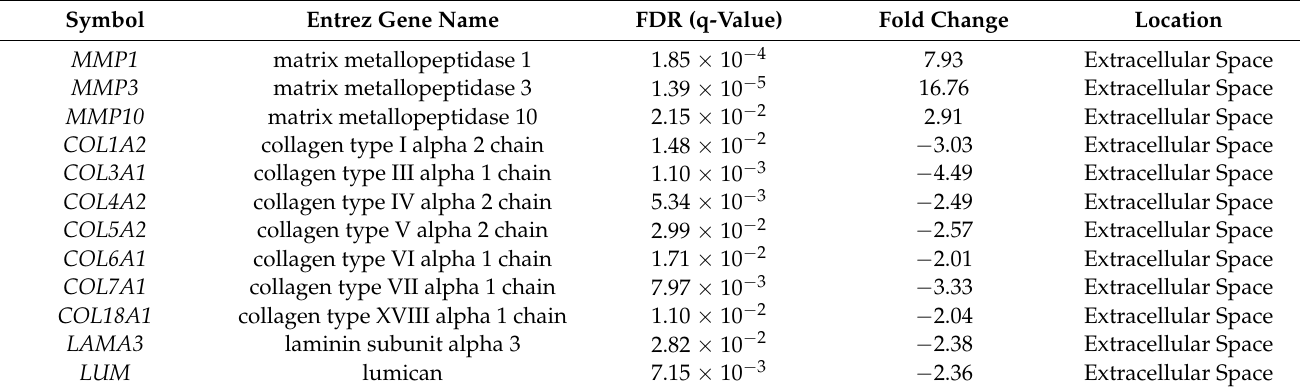
Table 2. Differential Expression of ECM and MMP transcripts between CR-LM6 and